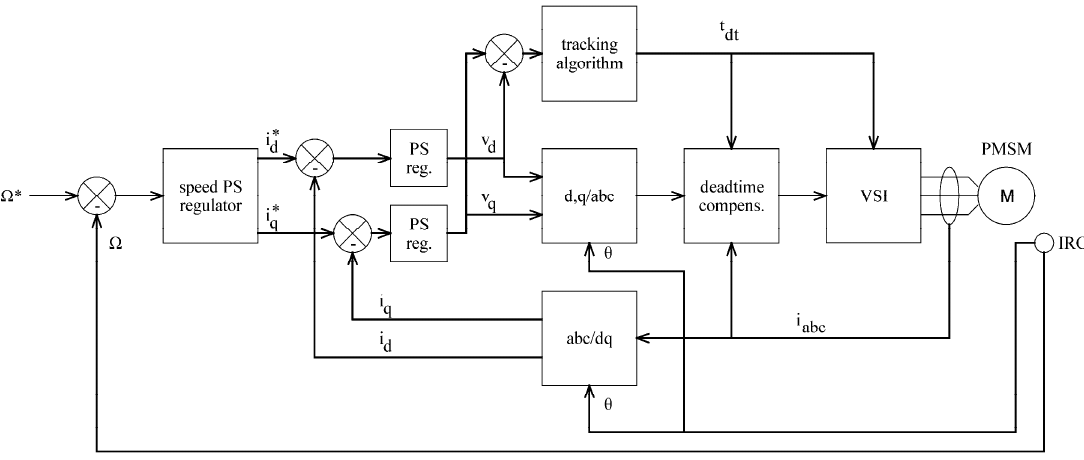
Figure 5. Proposed control scheme.